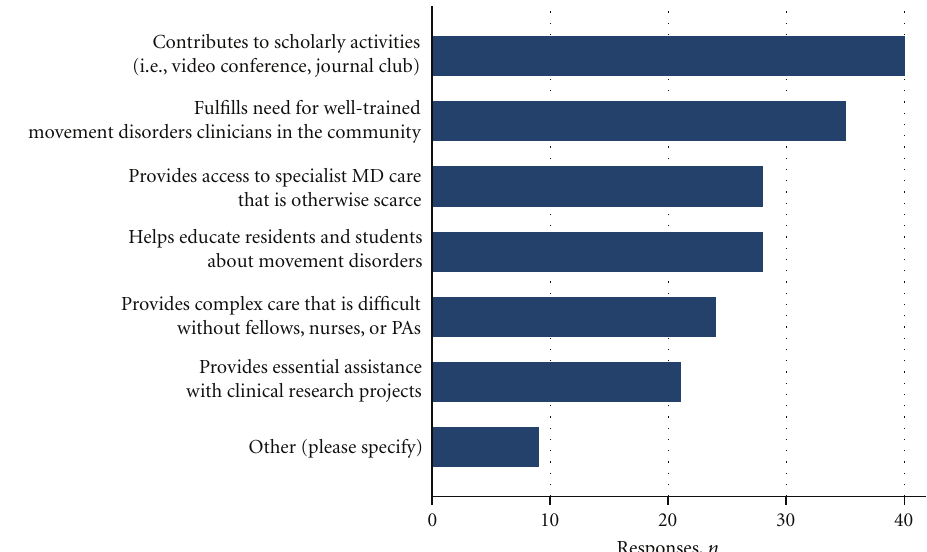
Figure 5: Program directors’ opinions regarding the fellow’s role within the movement disorders center. Other responses include need for training leaders in clinical research and clinician scientists in the field ( 𝑛 = 3